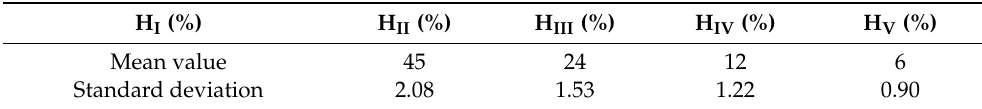
Table 3. The results of ultrasonic measurements used to determine the attenuation in samples produced with the additive technology (the complete set of results are available in the Appendix A in Table A1). H I (%) H II (%)